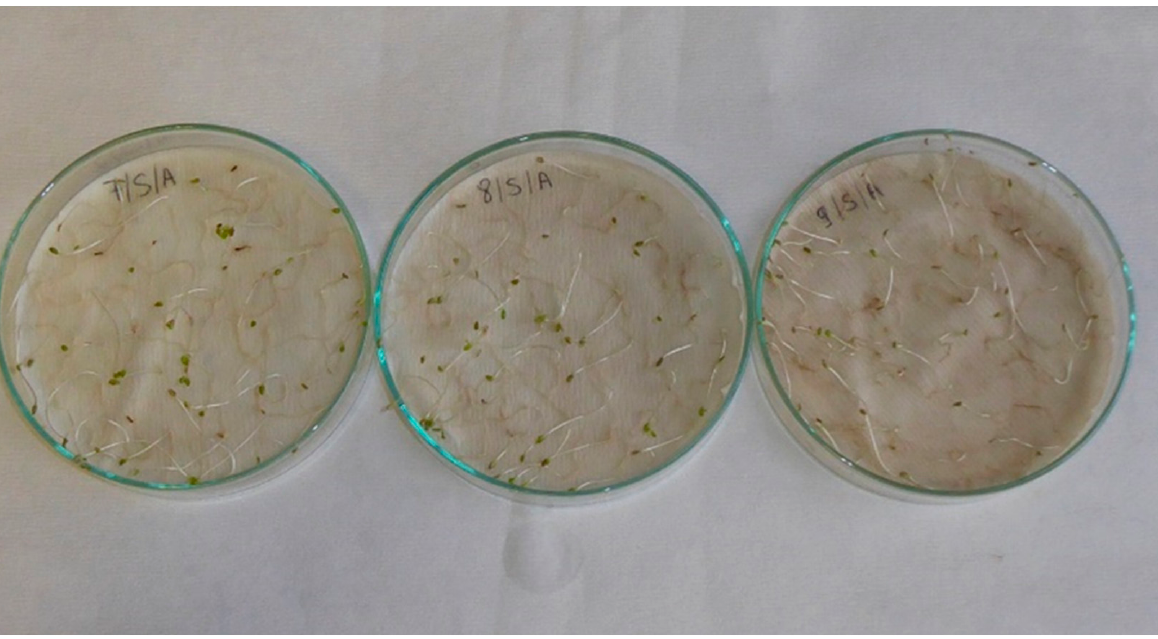
Figure A10. Lettuce ( Lactuca sativa L.) seedlings; treatments with aqueous extracts of black cumin ( Nigella sativa L.) in 2.5% concentration ( left ) 5% concentration ( middle ) and 10% concentration ( right ).